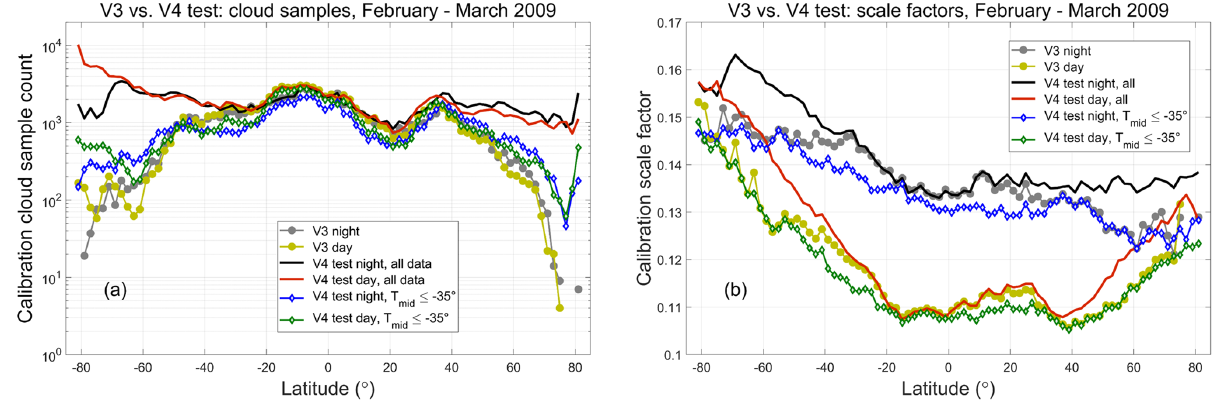
Figure 8. (a) Sample counts and (b) mean scale factors for all daytime and nighttime granules acquired during February and March 2009. V3 results are shown in yellow (day) and dark gray (night). The initial test results (new altitude regime only) are shown in red (day) and black (night). The test results with a − 35 ◦ C temperature requirement imposed are shown in green (day) and blue